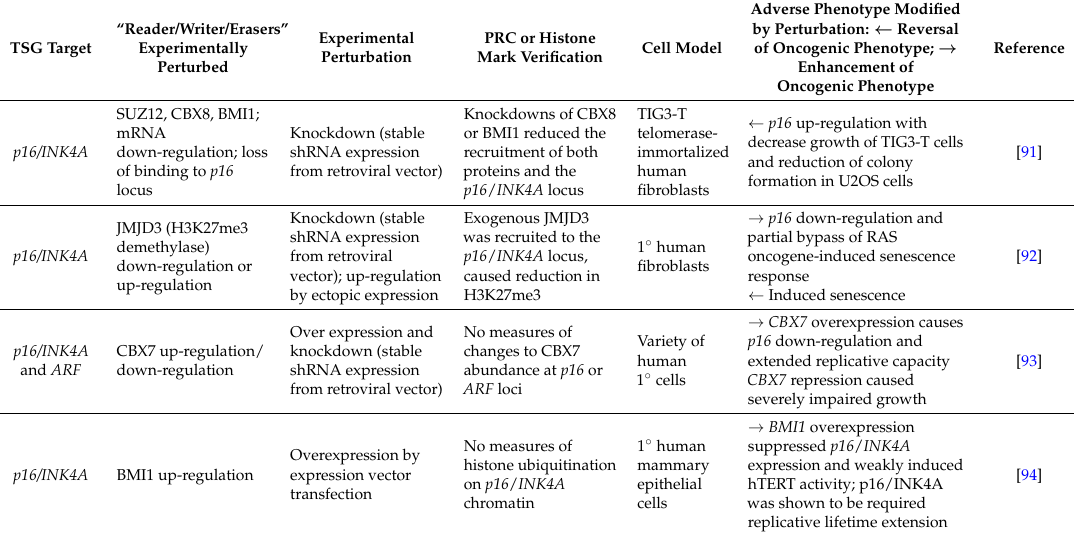
Table 2. Experimental studies employing molecular tools to modify polycomb group (PcG) components and thereby affect human cell growth